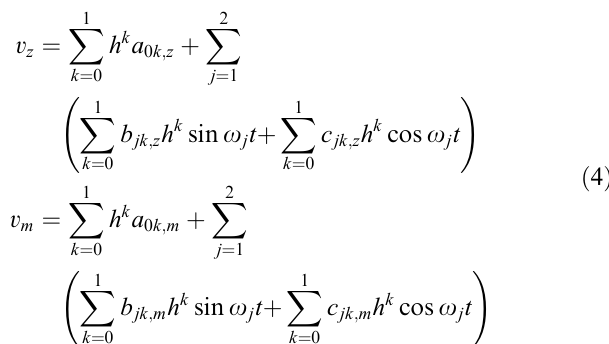
Fig. 7. Zonal amplitude v wave in June–August 1983–1996. The values are calculated from running 10-day data windows with a step rate of